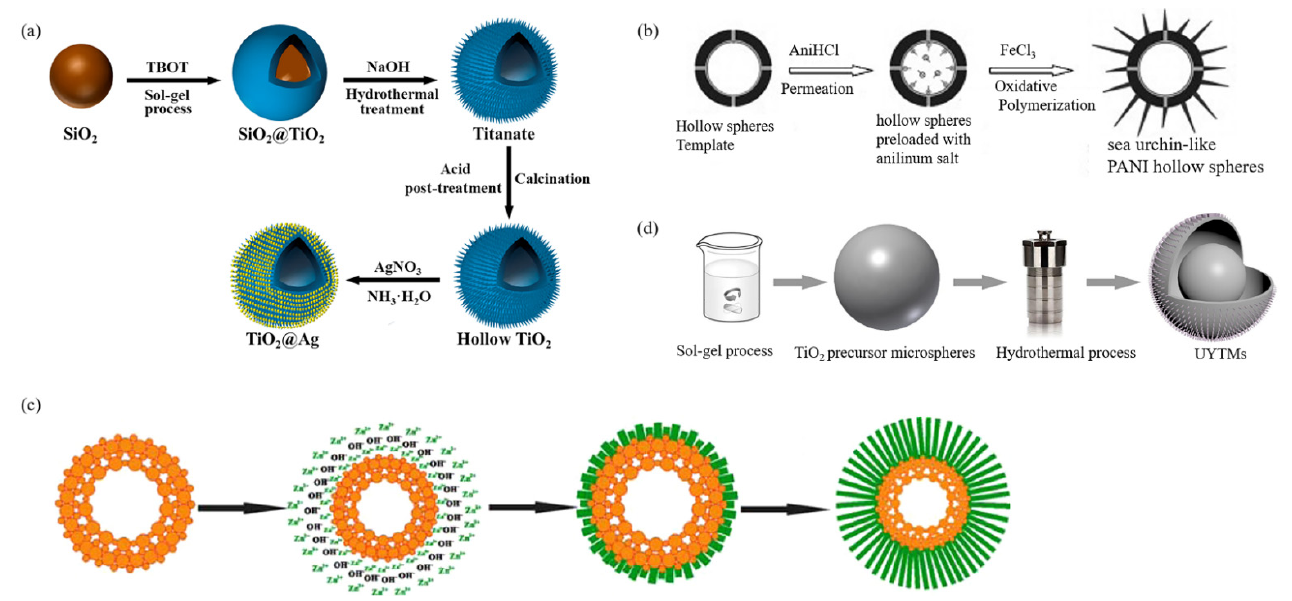
Figure 6. Examples of the preparation of urchin-like hollow micro-/nanoparticles by the step